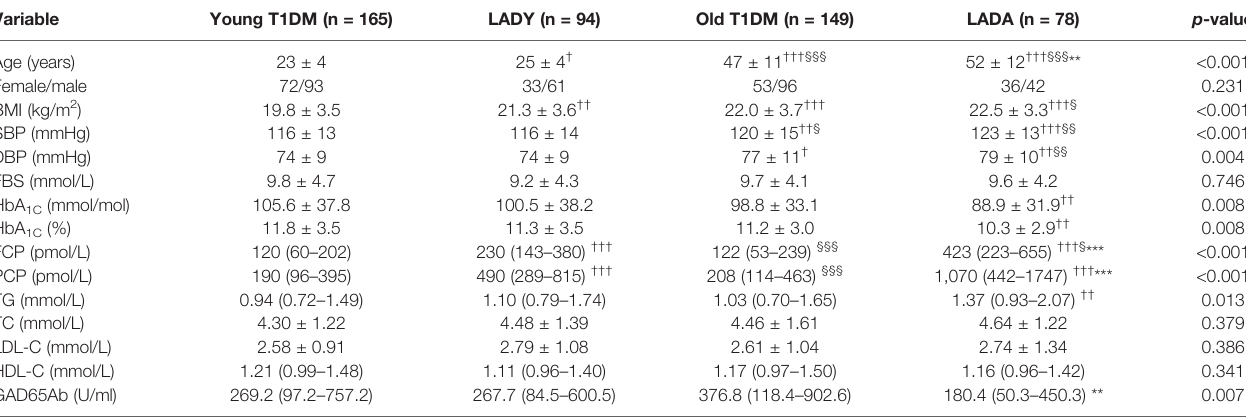
TABLE 2 | Comparison of clinical features of patients with young T1DM, LADY, old T1DM, and LADA.